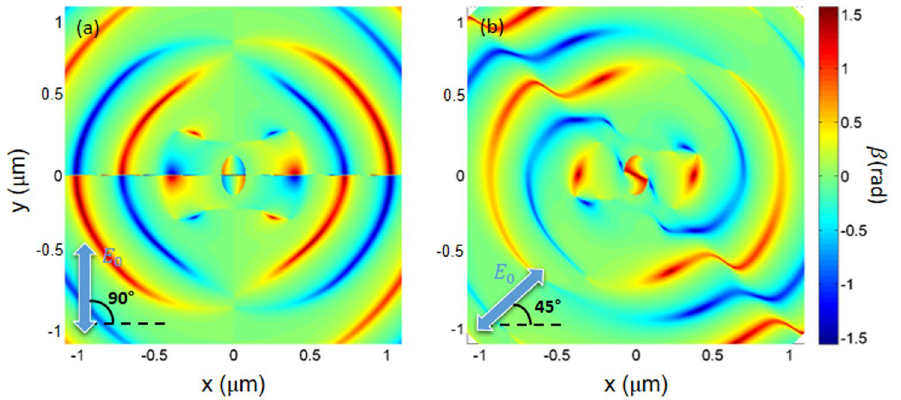
Figure 5. Numerical results: ( a ) Spatial distribution (2 μ m × 2 μ m) of the angle β that spin vector s forms with the xy -plane calculated by FEM simulations at 2 nm from the Au surface for an incident polarization direction coincident with the major axis of the elliptical nanohole at normal incidence. ( b ) Spatial distribution (2 μ m × 2 μ m) of the phase variation of the z -component of the total field calculated by FEM simulations at 2 nm from the Au surface for an incident polarization rotated of 45° respect to the major axis of the elliptical nanohole at normal